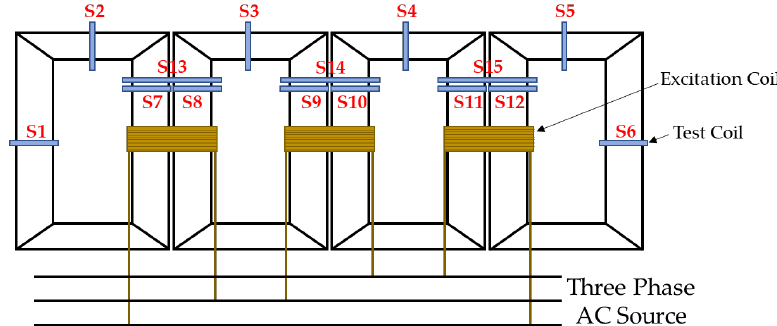
Figure 15. Setting diagram of the three-phase five-limb transformer.